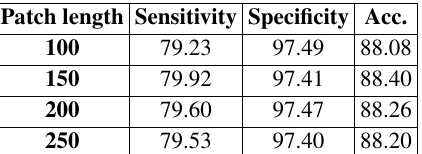
Patch length Sensitivity Specificity Acc.